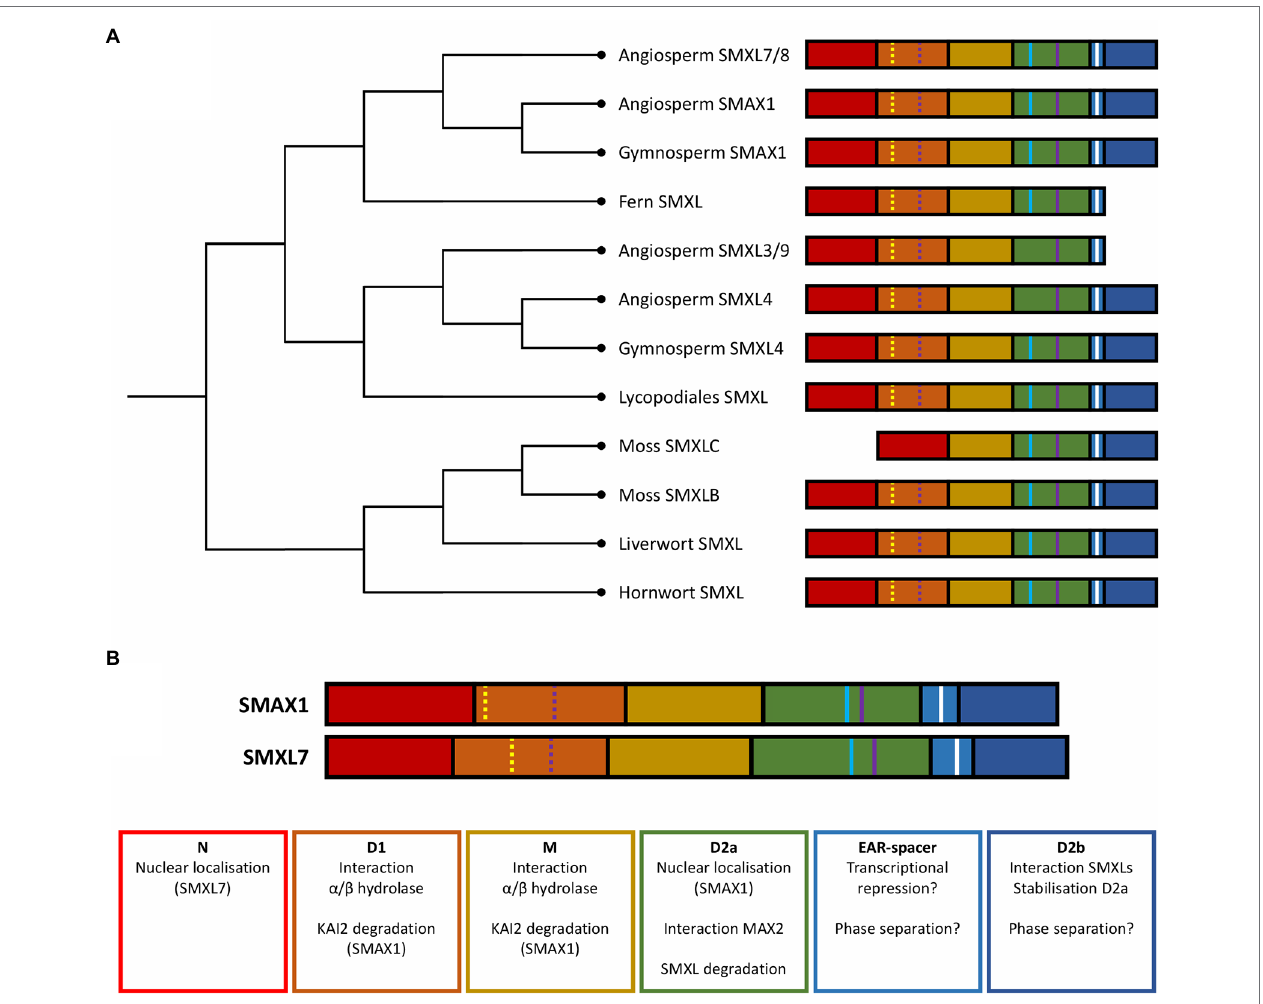
FIGURE 2 | Evolution and structure of SMXL proteins. (A) Dendrogram showing the phylogenetic relationships between the major SMXL clades in different land plants. (B) Function of the structural domains of Arabidopsis SMAX1 and SMXL7. Colored blocks represent structural domains: N domain (red), D1 domain (orange), M domain (yellow), D2 domain NTPase 1 (D2a; green), a spacer containing the EAR-motif (light blue), and D2 domain NTPase 2 (D2b; dark blue). Colored lines represent short amino acid motifs: Walker A motif (yellow line), Walker B motif (purple line), EAR motif (white), and RGKT motif